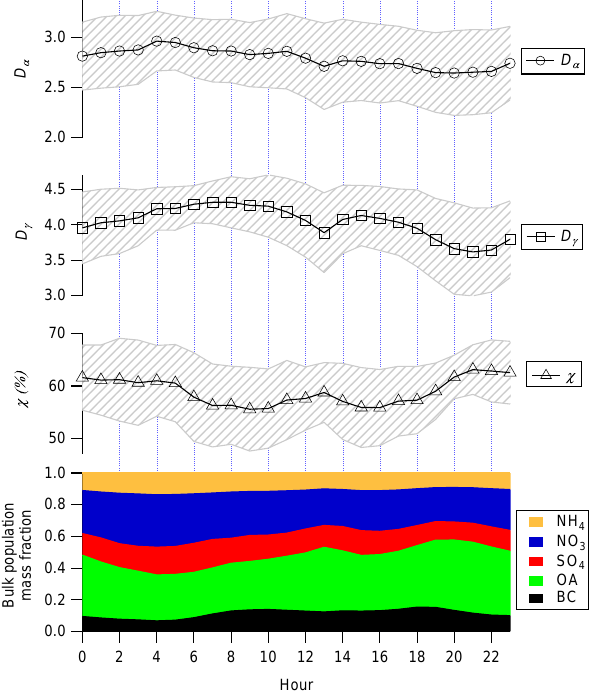
Figure 6. Dependence of average single particle diversity ( D α ) , av- erage bulk population diversity ( D γ ) , mixing state ( χ) and average bulk population composition upon time of day ( N = 26 days). The solid lines with the symbols are the campaign-averages for each hour. Shaded areas represent one standard deviation (1 σ) .